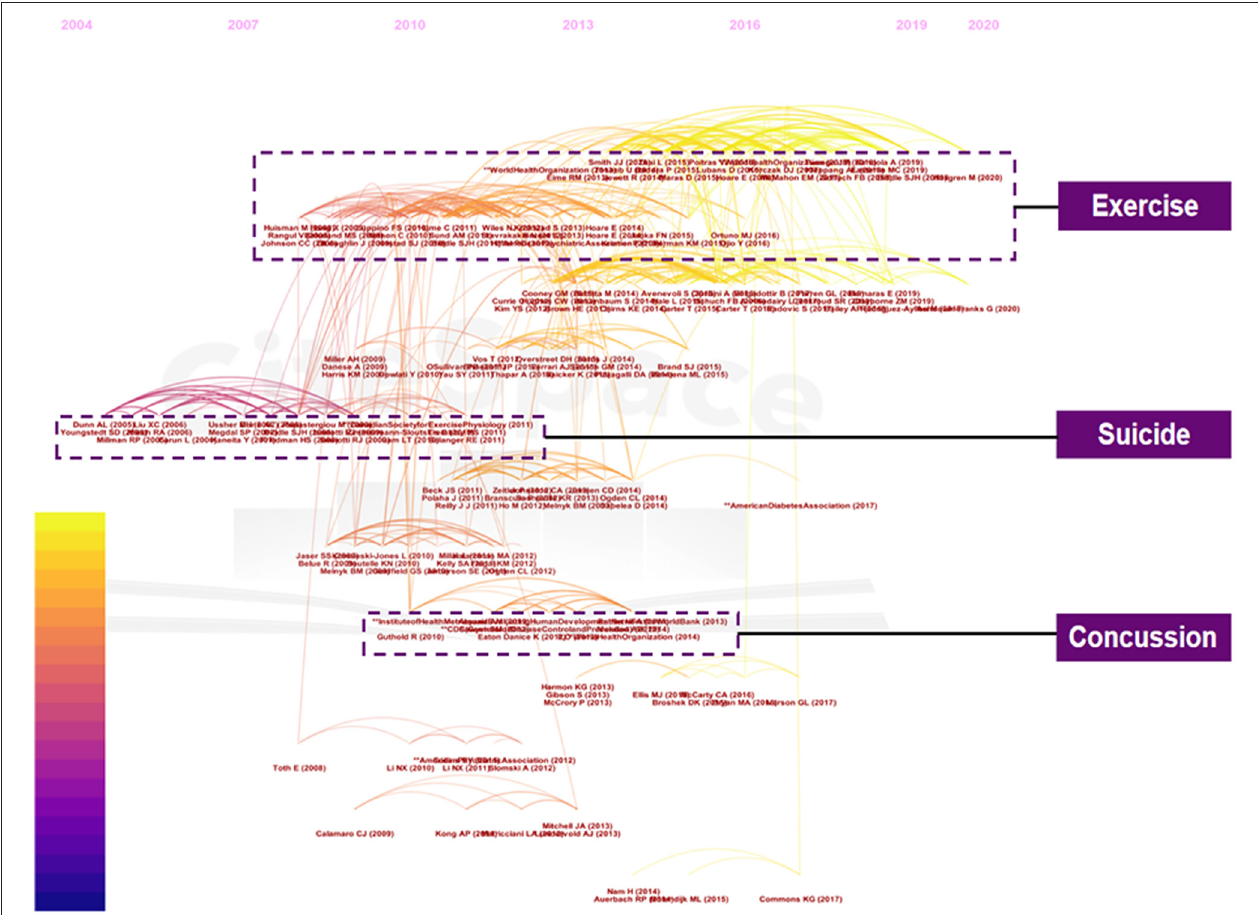
FIGURE 5 | The timeline view of the knowledge map based on reference co-citation analysis of the exercise-depression-teenager field from 2000 to